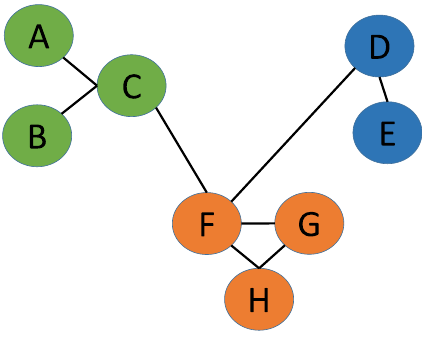
FIG. 2. Network diagram of constraints and structural holes. Node F has access to different sources of information from blue and green